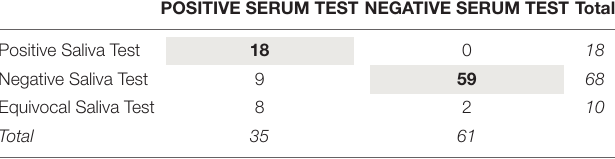
TABLE 4 | Correspondence between human cytomegalovirus IgG test results using serum and salivary biospecimens from healthy adults ( N = 96). POSITIVE SERUM TEST NEGATIVE SERUM TEST